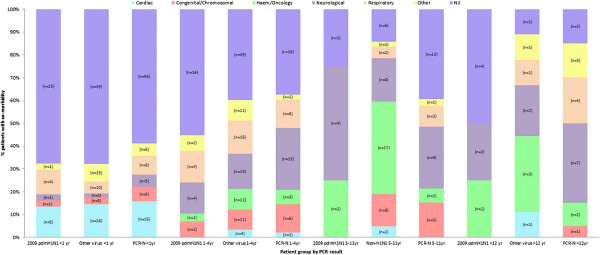
Co-morbidities in 2009 pdmH1N1 admissions versus admissions positive for other viruses or PCR-negative (PCR-N).